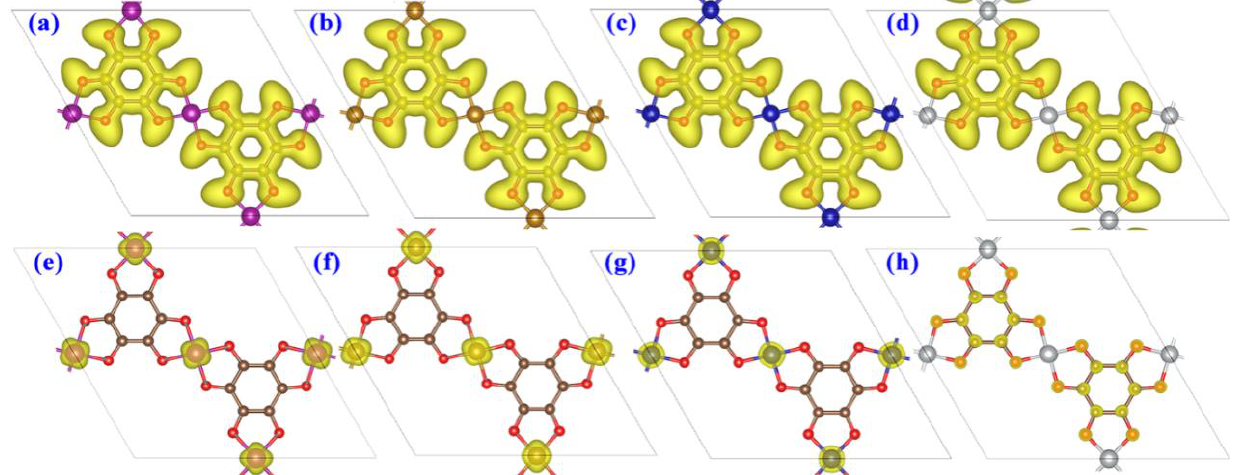
Figure 4. Electron localization function (ELF) of ( a ) Mn-O-MOF, ( b ) Fe-O-MOF, ( c ) Co-O-MOF, and ( d ) Ni-O-MOF. The spin density of ( e ) Mn-O-MOF, ( f ) Fe-O-MOF, ( g ) Co-O-MOF, and ( h ) Ni-O-MOF single-layer structures.